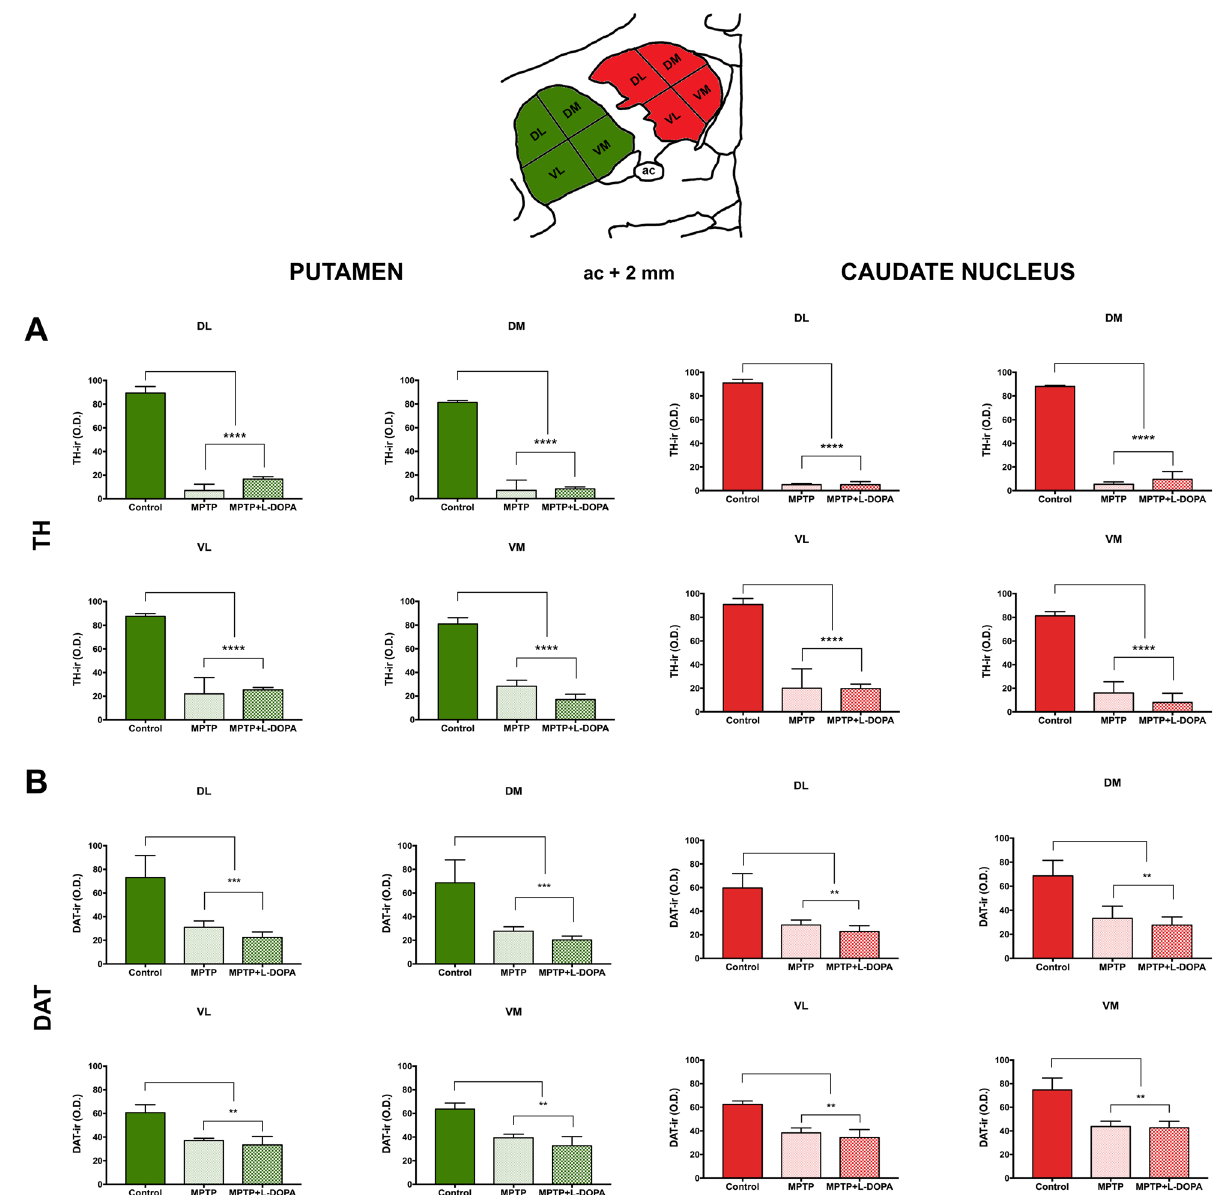
Figure 2. Striatal TH + ir fibers distribution and DAT expression in the anterior striatum (anterior commissure = + 2 mm). ( A ) Quantification of TH optical density in the putamen (left, green) and caudate nucleus (right, red). ( B ) Quantification of DAT optical density in the putamen (left, green) and caudate nucleus (right, red). Data were compared by one-way ANOVA (Putamen. TH: DL, F (2,9) = 273.7, P < 0.0001; DM F (2,9) = 195.4, P < 0.0001; VL, F (2,9) = 40.42, P < 0.0003; VM, F (2,9) = 139.2, P < 0.0001. DAT: DL, F (2,9) = 42.50, P = 0.0003; DM, 42.41, P = 0.0003; VL, F (2,9) = 26.30, P = 0.0011; VM, F (2,9) = 34.94, P = 0.0005. Caudate nucleus. TH: DL, F (2,9) = 1047, P < 0.0001; DM F (2,9) = 276, P < 0.0001; VL, F (2,9) = 43.05, P = 0.0003; VM, F (2,9) = 64.95, P < 0.0001. DAT: DL, F (2,9) = 18.07, P = 0.0029; DM, 15.27, P = 0.0044; VL, F (2,9) = 26.11, P = 0.0011; VM, F (n = 4 biological replicates and 7 technical replicates/animal). Ac anterior commissure, DAT dopamine transporter, DL dorsolateral, DM dorsomedial, VL ventrolateral, VM ventromedial, TH tyrosine